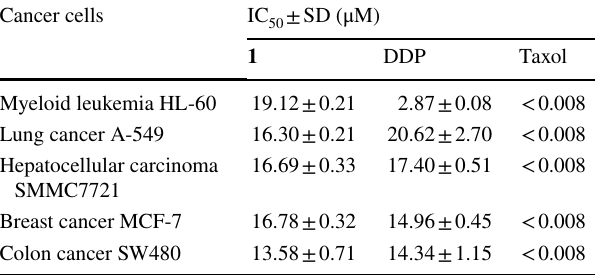
Table 3 Cytotoxicities of compound 1 against five human cancer cell lines